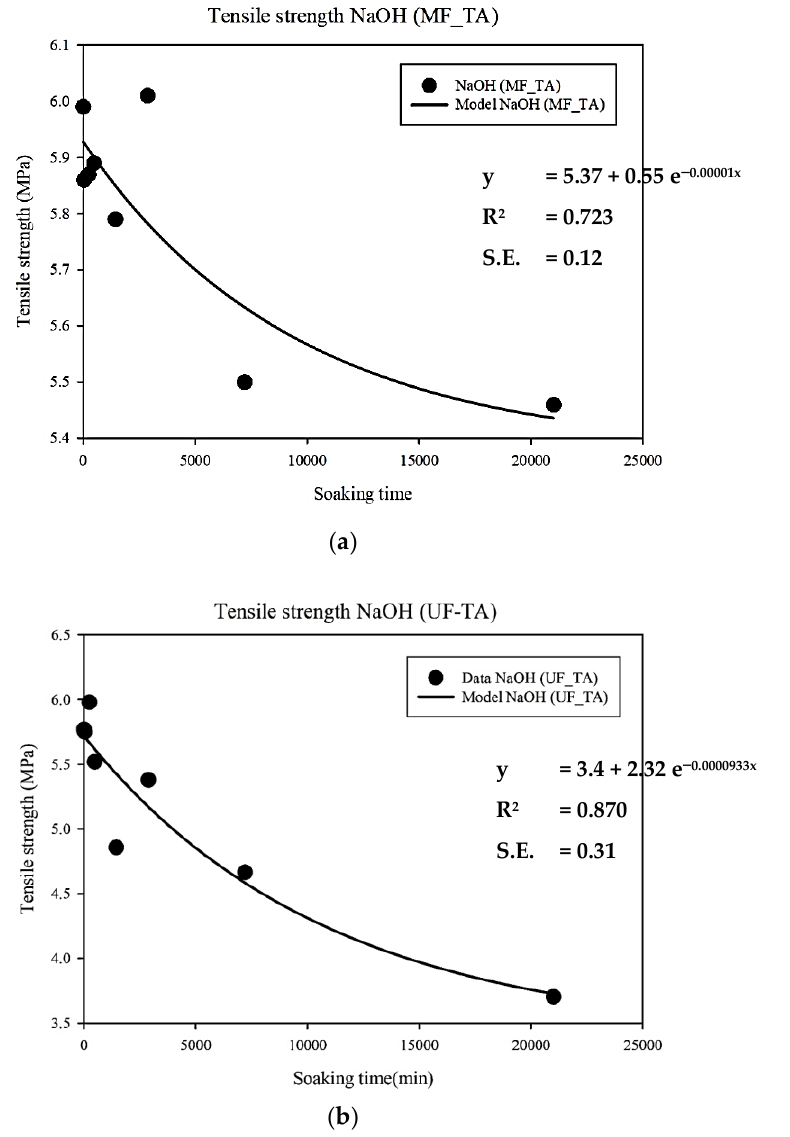
Figure 6. Tensile strength of ( a ) MF and ( b ) UF membranes filtrated with TA after soaking in NaOH solution. Fitting performed by exponential equations. S.E. stands for standard error.